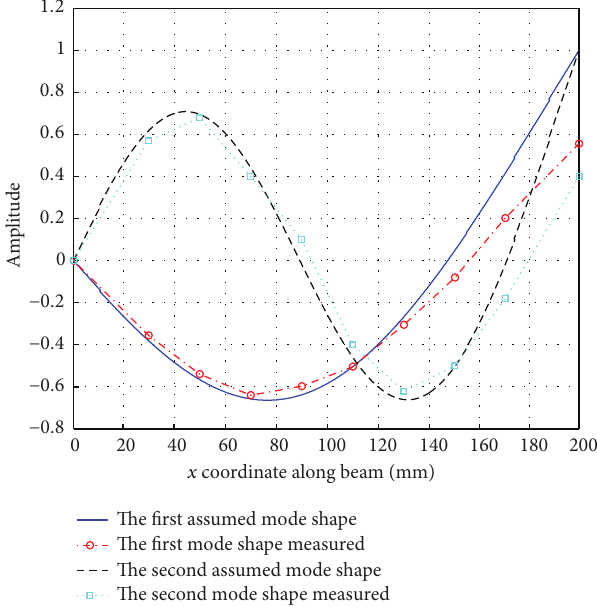
Figure 3: First two mode shapes of the flexible link identified.